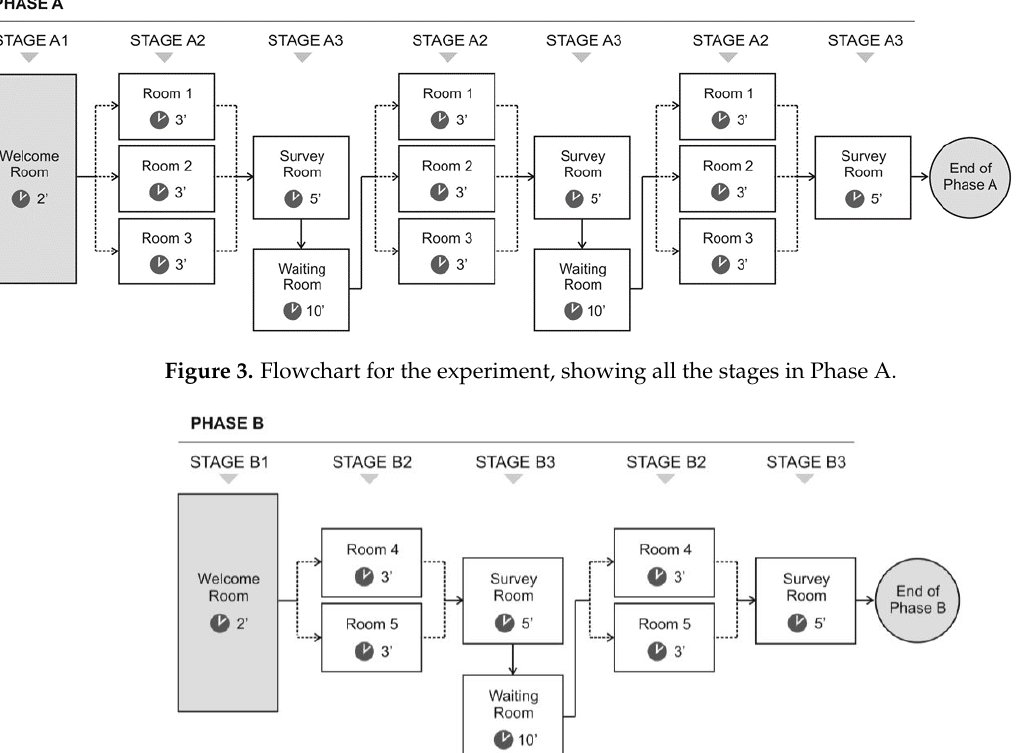
Figure 3. Flowchart for the experiment, showing all the stages in Phase A.